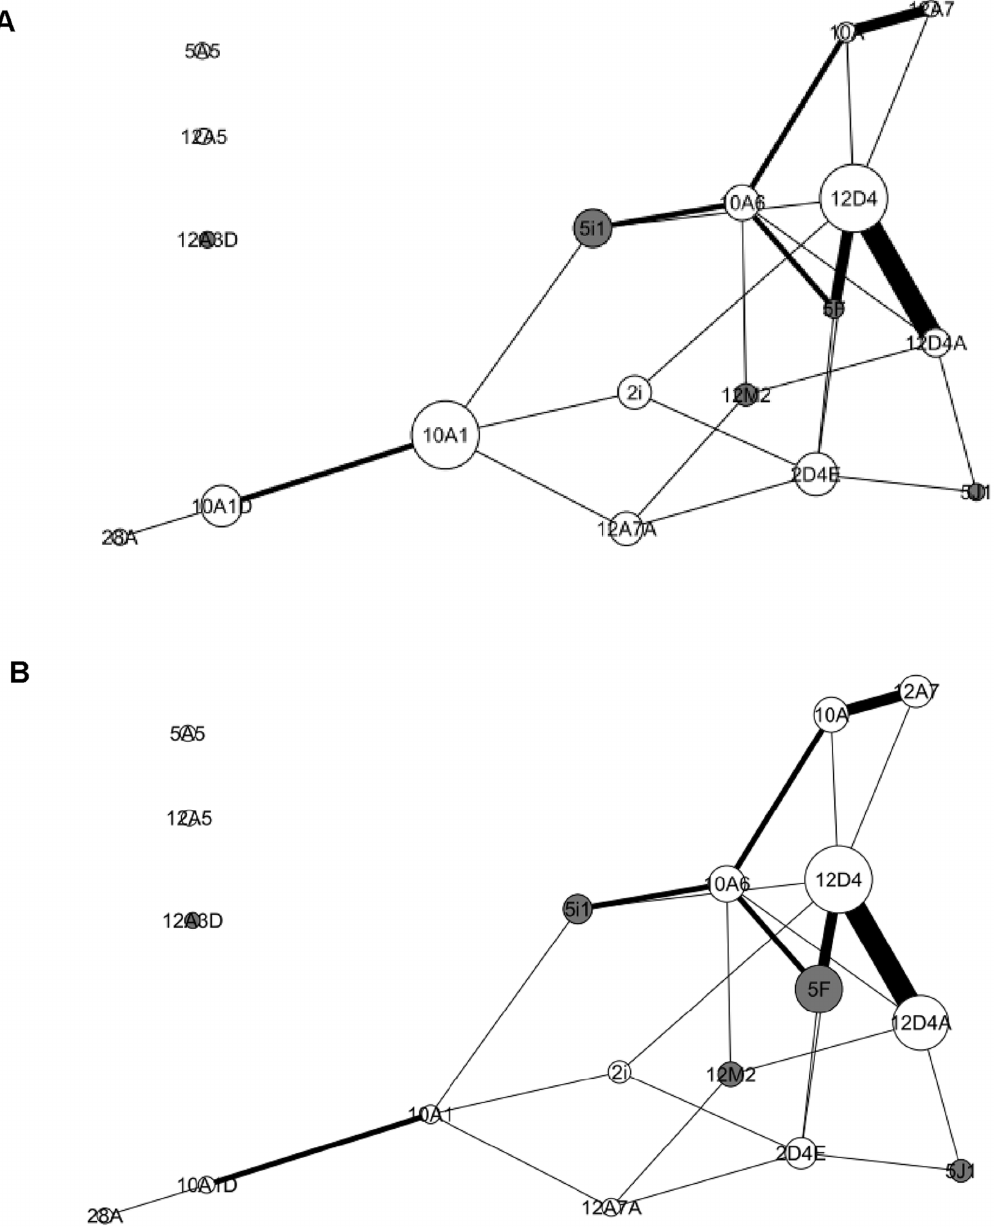
Figure 2. Representation of the contactnetwork . Nodes represent individuals, and the size of nodes is related to the individual’s betweenness (A) and the individual’s eigenvector centrality (B), with bigger nodes corresponding to more central individuals. White nodes correspond to females and dark gray nodes correspond to males. Widths of lines represent the strength of association between two individuals.